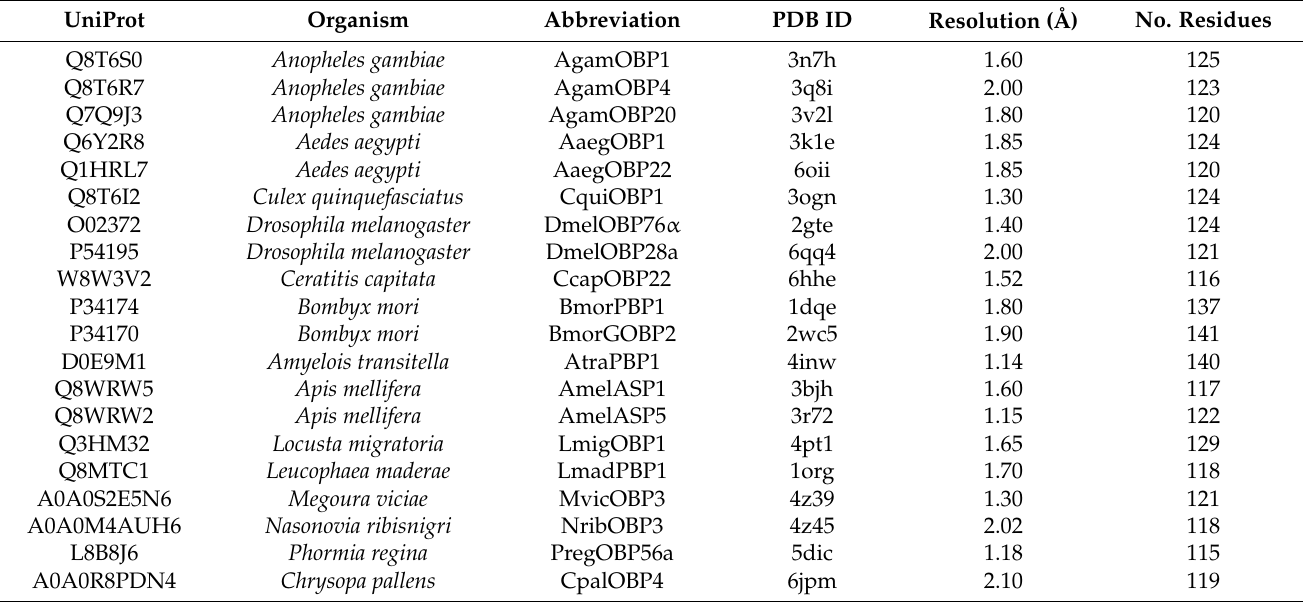
Table 1. The OBP dataset used in this